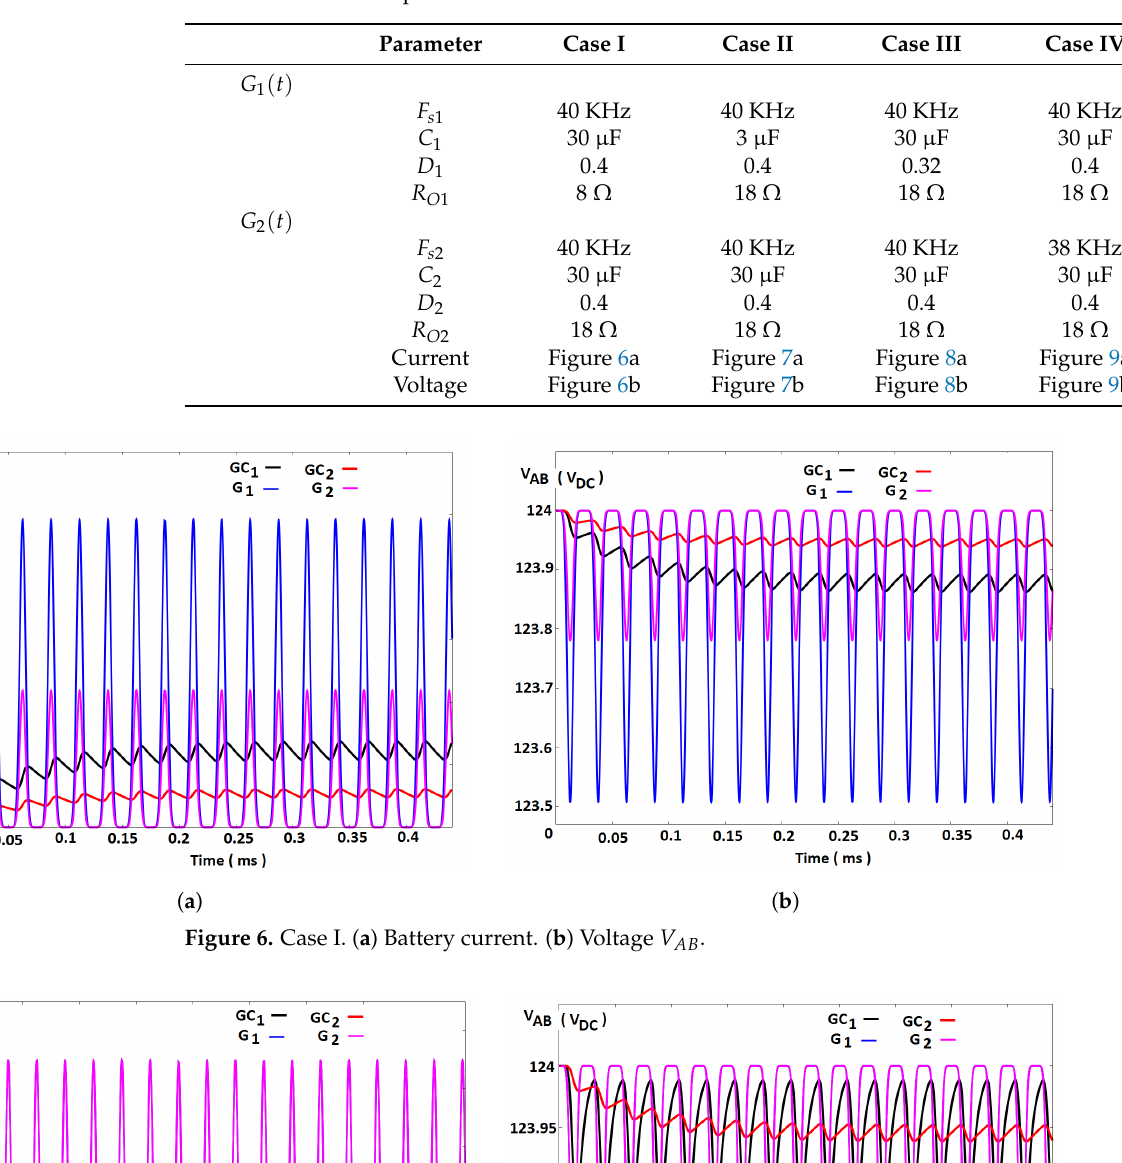
Table 1. Values of the parameters.